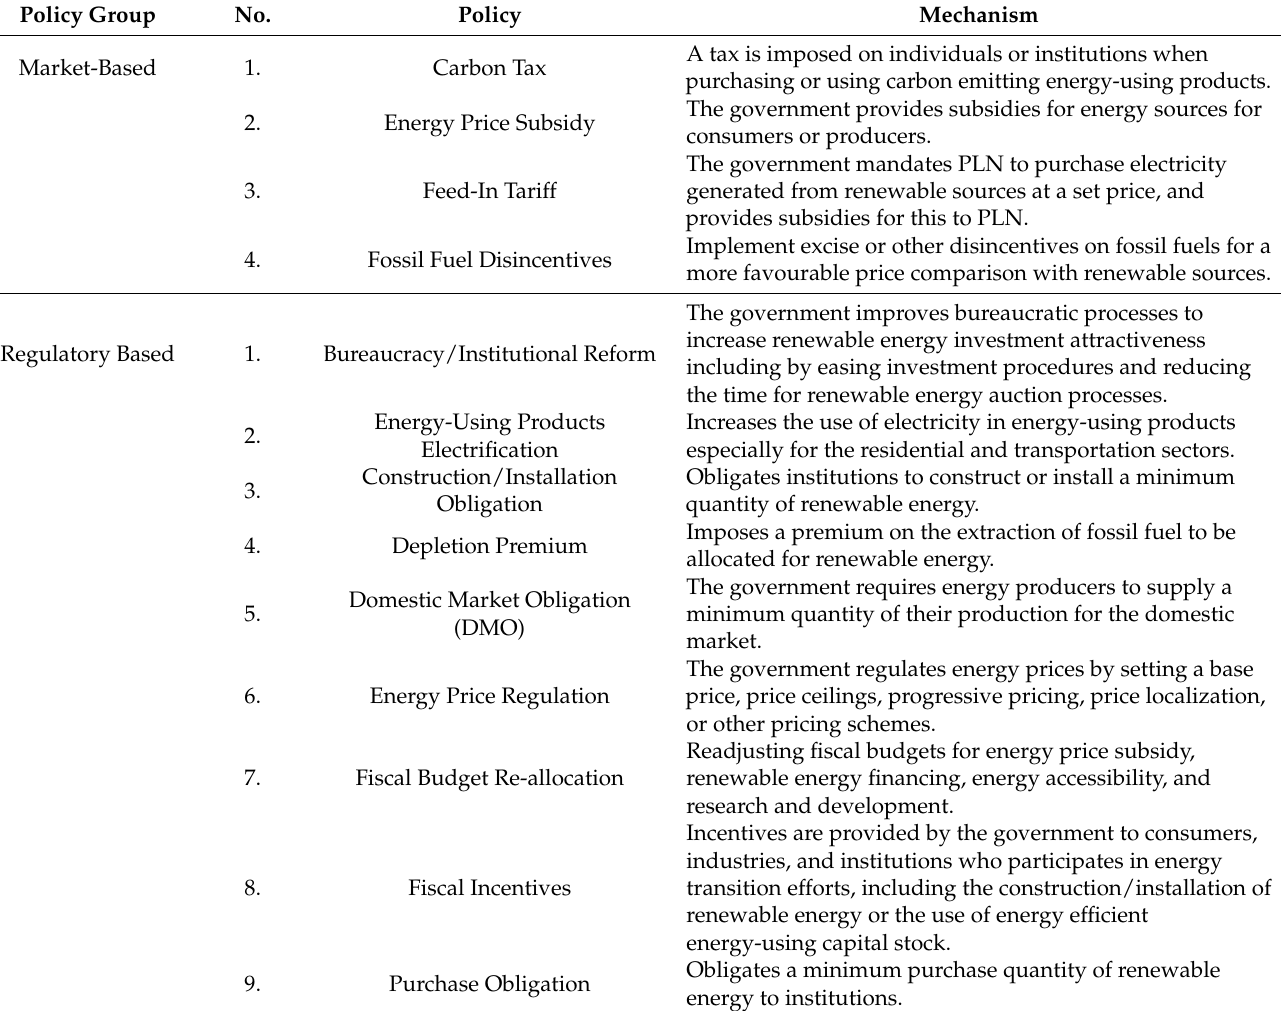
Table 1. Renewable energy transition policy in the electricity generation sector